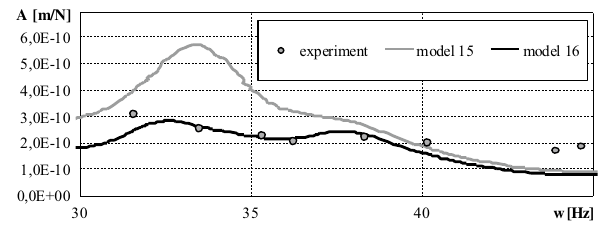
Fig. 17 Dependences of the displacement amplitudes of the forced oscillations of the support No. 4 on the frequencies for models 15 (hard contact) and 16 (variable contact)